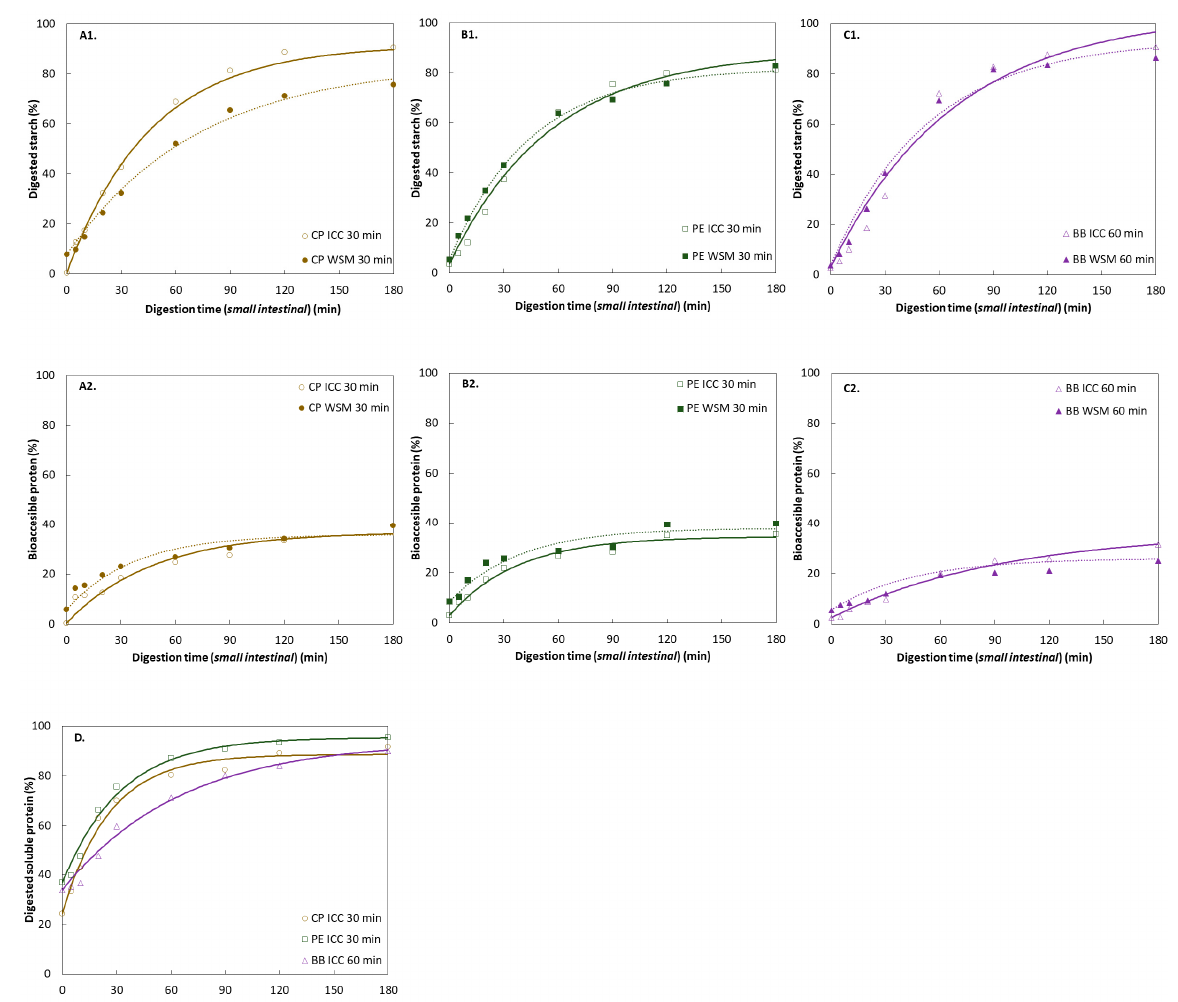
6 Figure 6. In vitro starch ( A – C1 ) and protein ( A – C2 , D ) small intestinal digestion kinetics of individual cotyledon cells (ICC) ( open symbols) and whole seed material (WSM) ( • closed symbols) from (cid:35) hardness-aligned chickpea (CP) ( • ) ( A ), pea (PE) ( (cid:4) ) ( B ), or black beans (BB) ( (cid:78) ) ( C ) hydrothermally treated for 30, 30, or 60 min, respectively. Symbols represent experimental values, while lines represent values predicted by a fractional conversion model (Equation (4)). Table 2. Estimated kinetic parameters ± standard deviation of in vitro starch digestion of individual cotyledon cells (ICC) and whole pulse seeds (WSM) from chickpea (CP), pea (PE), or black bean (BB) aligned to equivalent hardness levels using hydrothermal treatment for 30, 30, or 60 min, respectively. Starch digestion kinetic parameters were estimated by fitting the experimental data to a fractional conversion model (Equation (4)). Mean values (within a column) with different superscript letters are significantly different based on 95% confidence